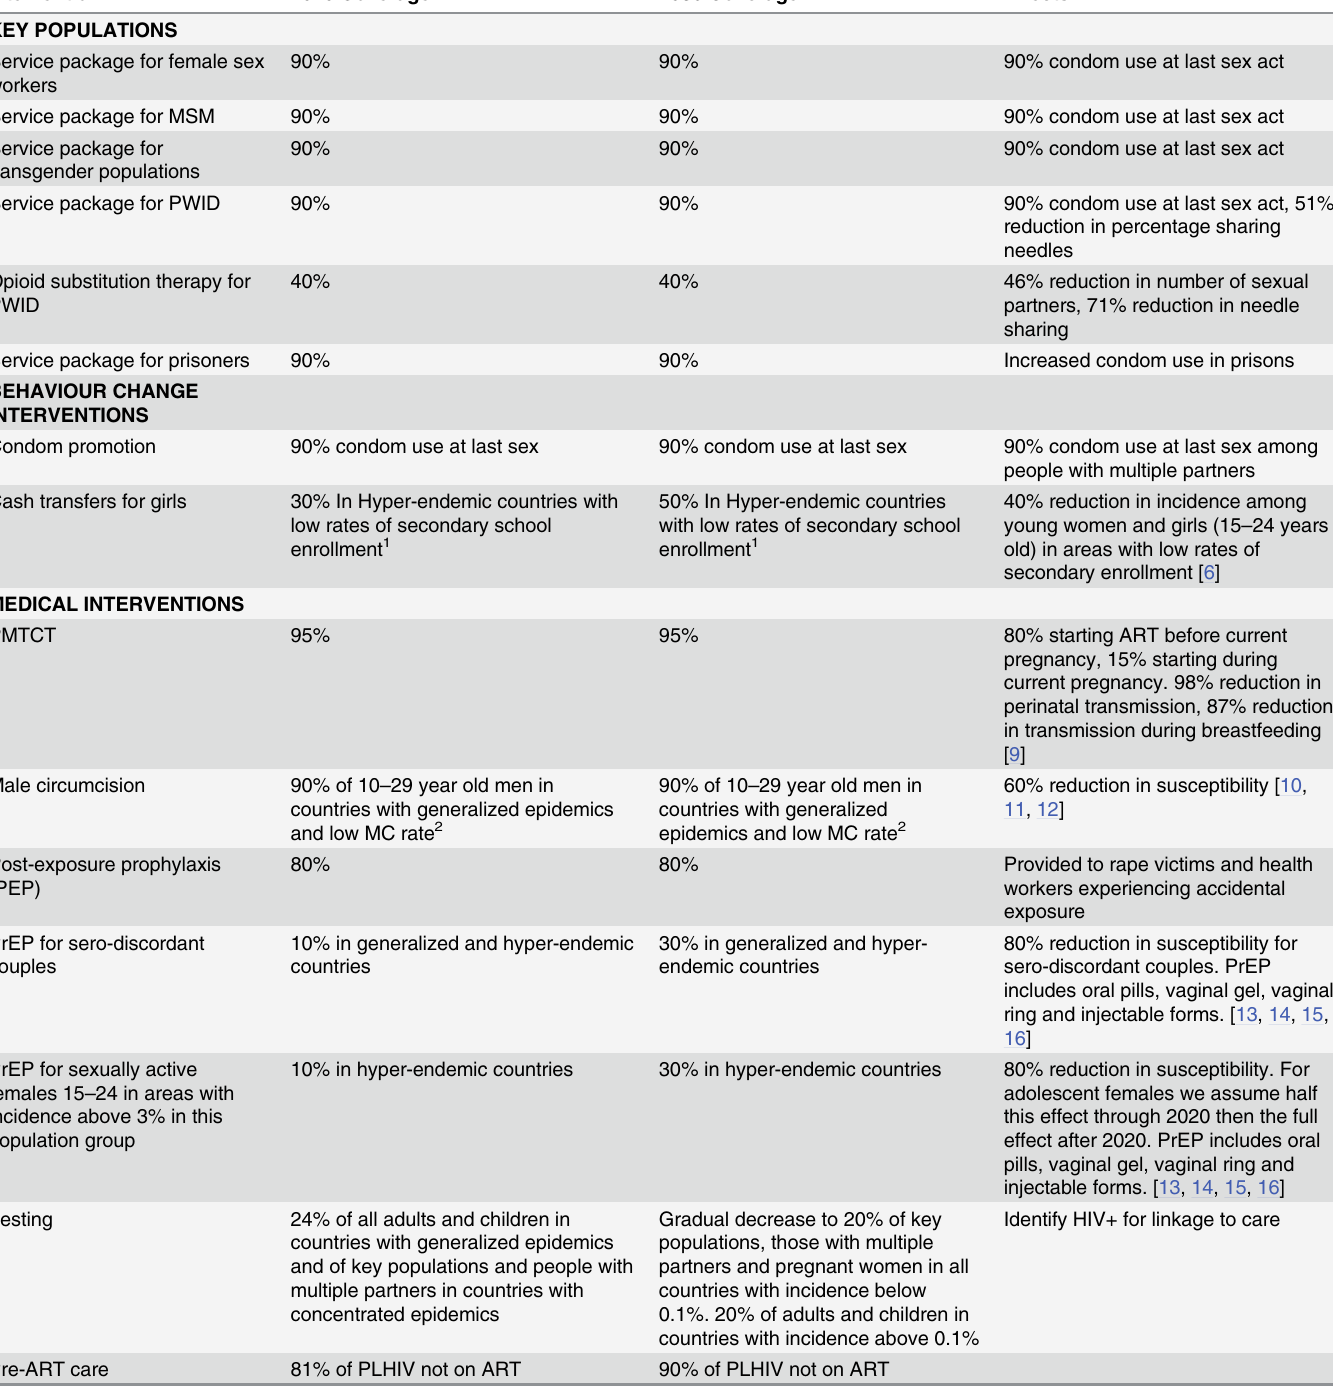
Table 1. Coverage goals and effects for the interventions included in this